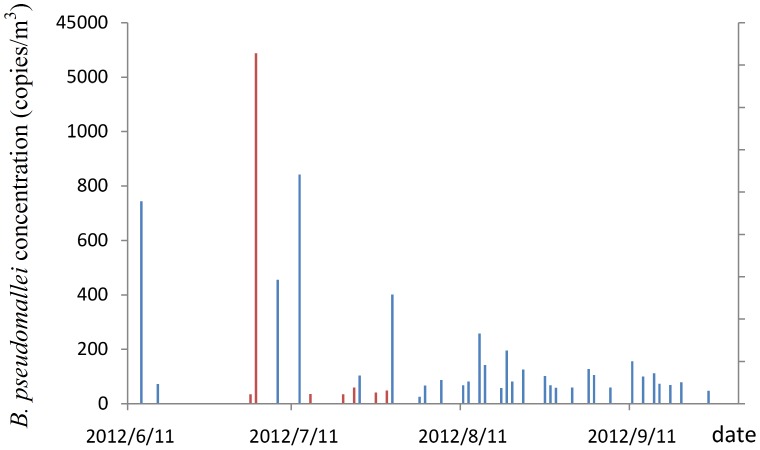
The ambient B. pseudomallei concentration profile from June to September 2012.